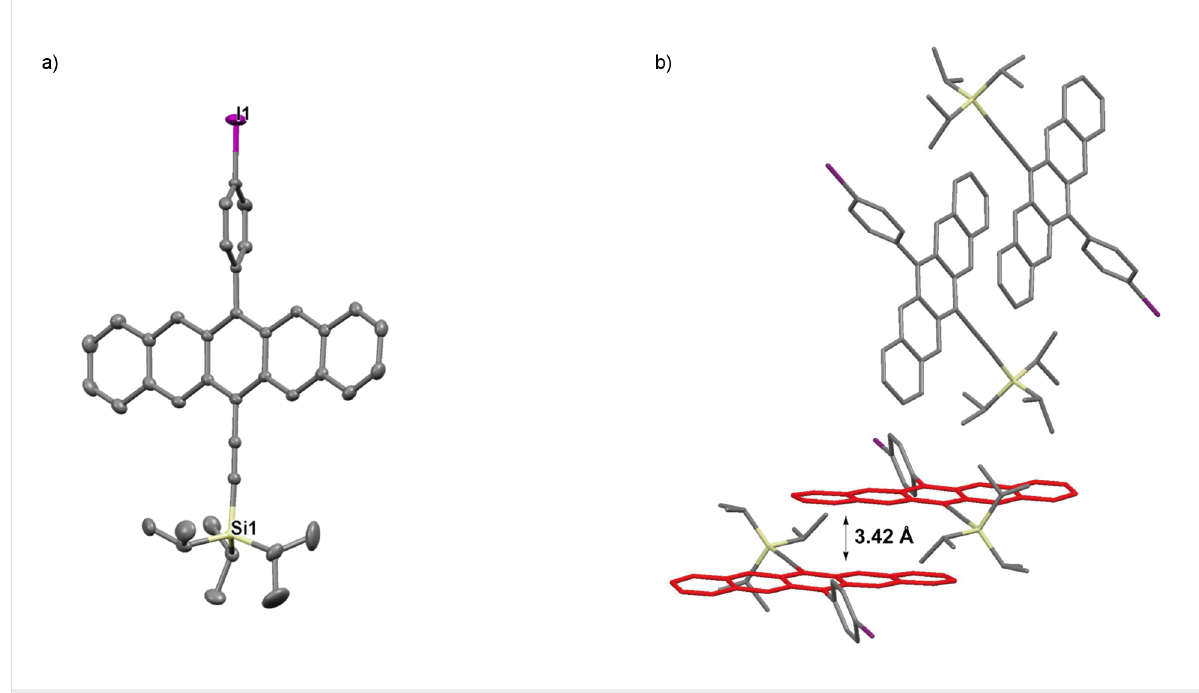
Figure 9: X-ray crystallographic analysis of 3g showing a) molecular structure and b) packing motif; ORTEP drawn at 50% probability level.